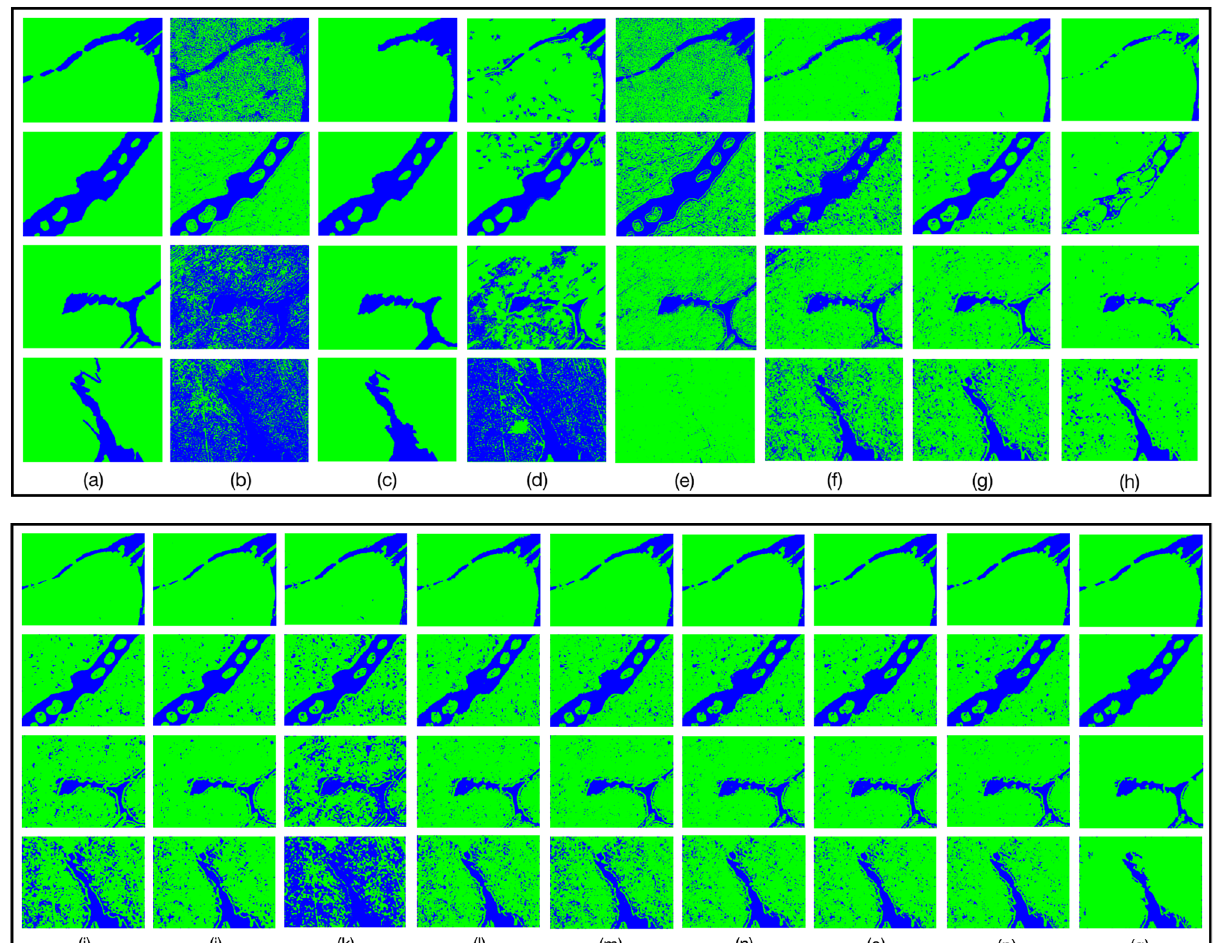
Figure 4. Comparison between our CES method with other methods. ( a ) ground truth; ( b ) MRF algorithm; ( c ) watershed algorithm; ( d ) Han’s algorithm; ( e ) meanshift algorithm; ( f ) DT; ( g ) KNN; ( h ) K-means; ( i ) Naive Bayes; ( j ) SVM (RBF); ( k ) SVM (Sigmoid); ( l ) RF; ( m ) AdaBoost; ( n ) XGBoost; ( o ) DART; ( p ) GBDT (our classifier); ( q ) CES (GBDT and post-processing